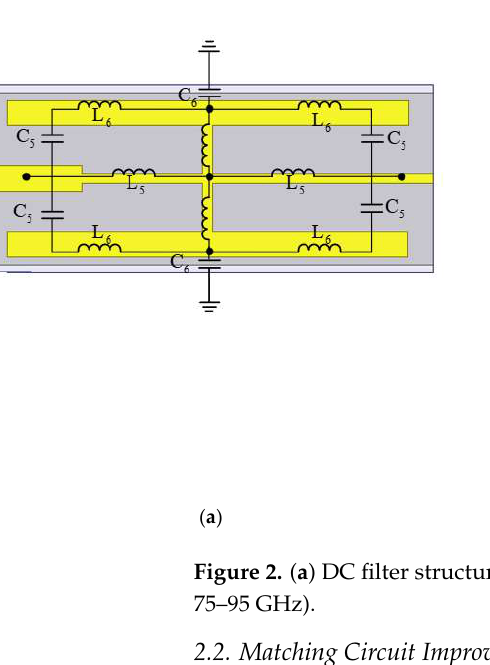
Figure 2. ( a ) DC filter structure; ( b ) simulation results of the DC filter (S11 > 21 dB, S21 < 0.2 dB at 75–95 GHz).